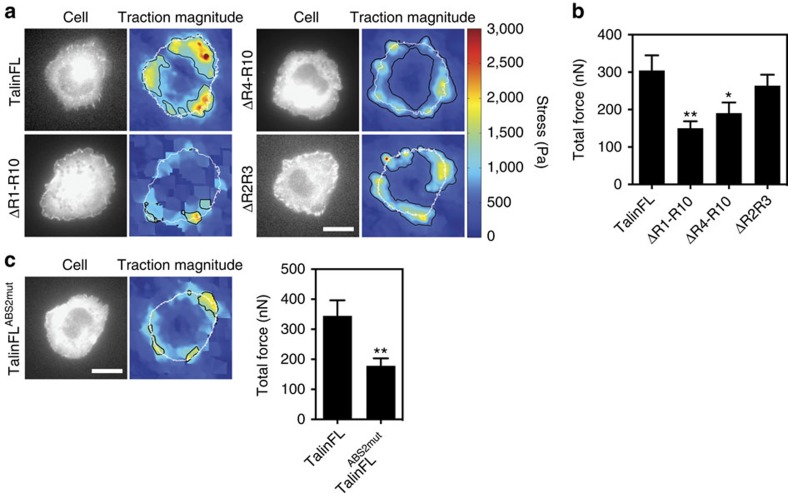
The link between talin ABS2 and F-actin is critical for force exertion.(a) Representative images from traction force microscopy (TFM) experiments. Colour spectrum indicates stress magnitude (Pa), with areas of low traction in blue and high traction in red. (b) Quantification of total force (nN) from TFM experiments shows that TKO cells expressing constructs lacking ABS2 (talΔR1-R10 and talΔR4-R10) exert less force than cells expressing talinFL (n=26–46 cells, error bars are±s.e.m., *=P<0.05, **=P<0.01 compared with talinFL (ANOVA)). (c) TFM experiments were repeated with the talinFLABS2mut construct. Cells expressing talinFLABS2mut had reduced force exertion compared with cells expressing talinFL (n=21–30 cells, error bars are±s.e.m., **=P<0.01 (t-test)). Scale bars in a and c, 10 μm.